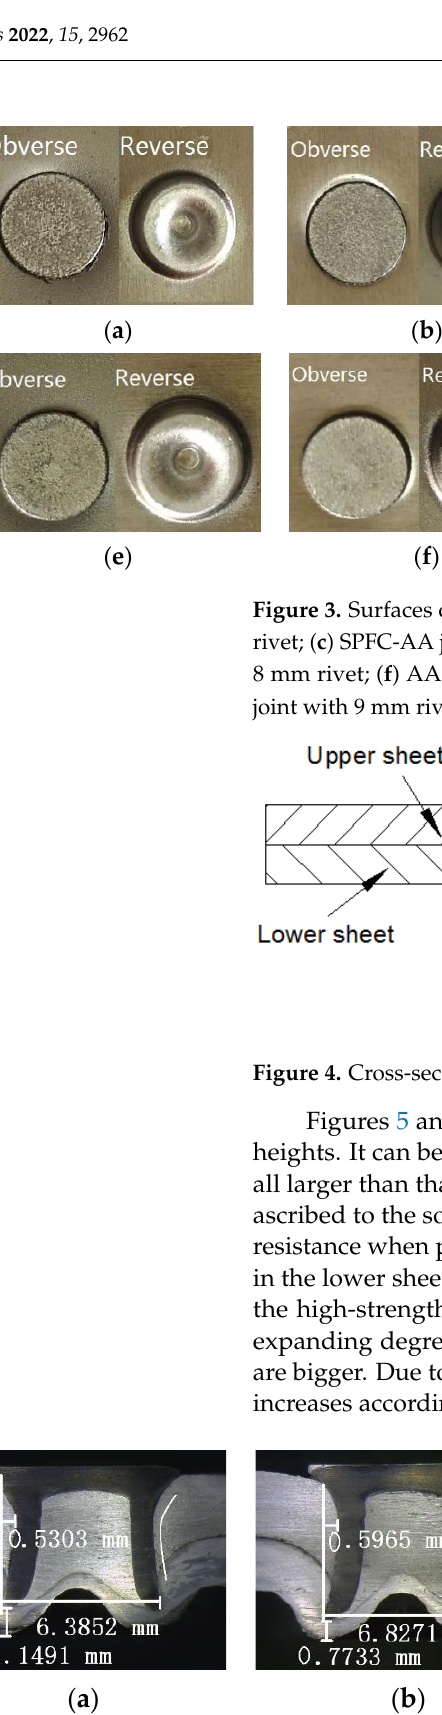
Figure 5. Cross-sectional profiles of AA-SPFC joints at rivet heights of ( a ) 6 mm; ( b ) 7 mm; ( c ) 8 mm; ( d ) 9 mm.